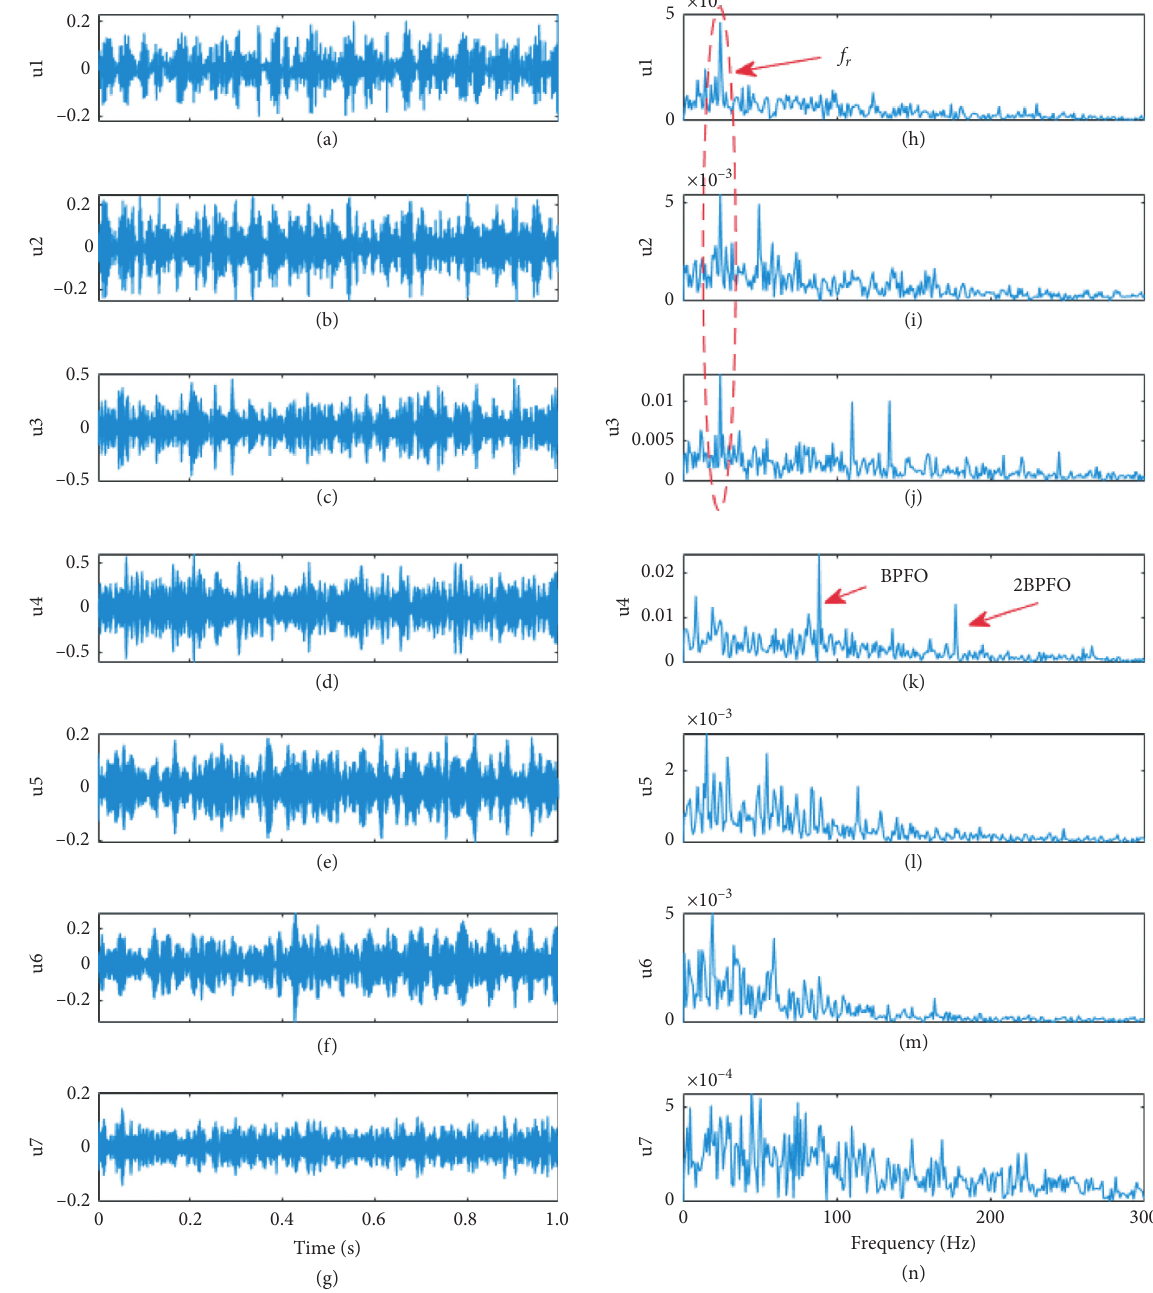
Figure 23: Experimental signals of case 1: signal processing results based on PAVMD: (a–g) time-domain waveform of each mode and (h–n) the corresponding squared envelope